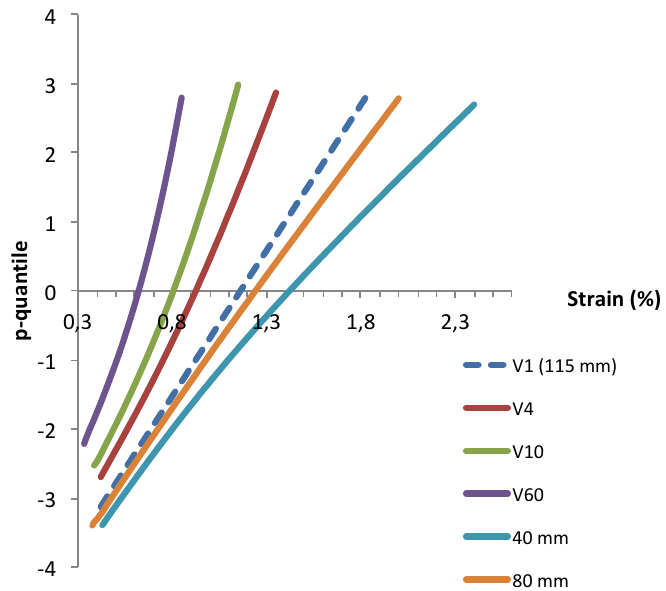
Figure 6. P-quantile z p ( ε ) diagrams predicted from the diagram at 115 mm gauge length; gauge lengths: 40 mm, 80 mm, 460 mm (V4), 1150 mm (V10) and 6900 mm (V60). Table 4. Predictions from 115 mm quantile diagram: values of mean ( µ ) and standard deviation ( s ) derived from the slope (1/ s ) and the intercept ( µ / s ) of the predicted z p ( ε p ) curves. R 2 is the coefficient of determination that measures the global fit of Equation (6) to predictions. Also given are the statistical parameters of Weibull distribution function derived from µ and s